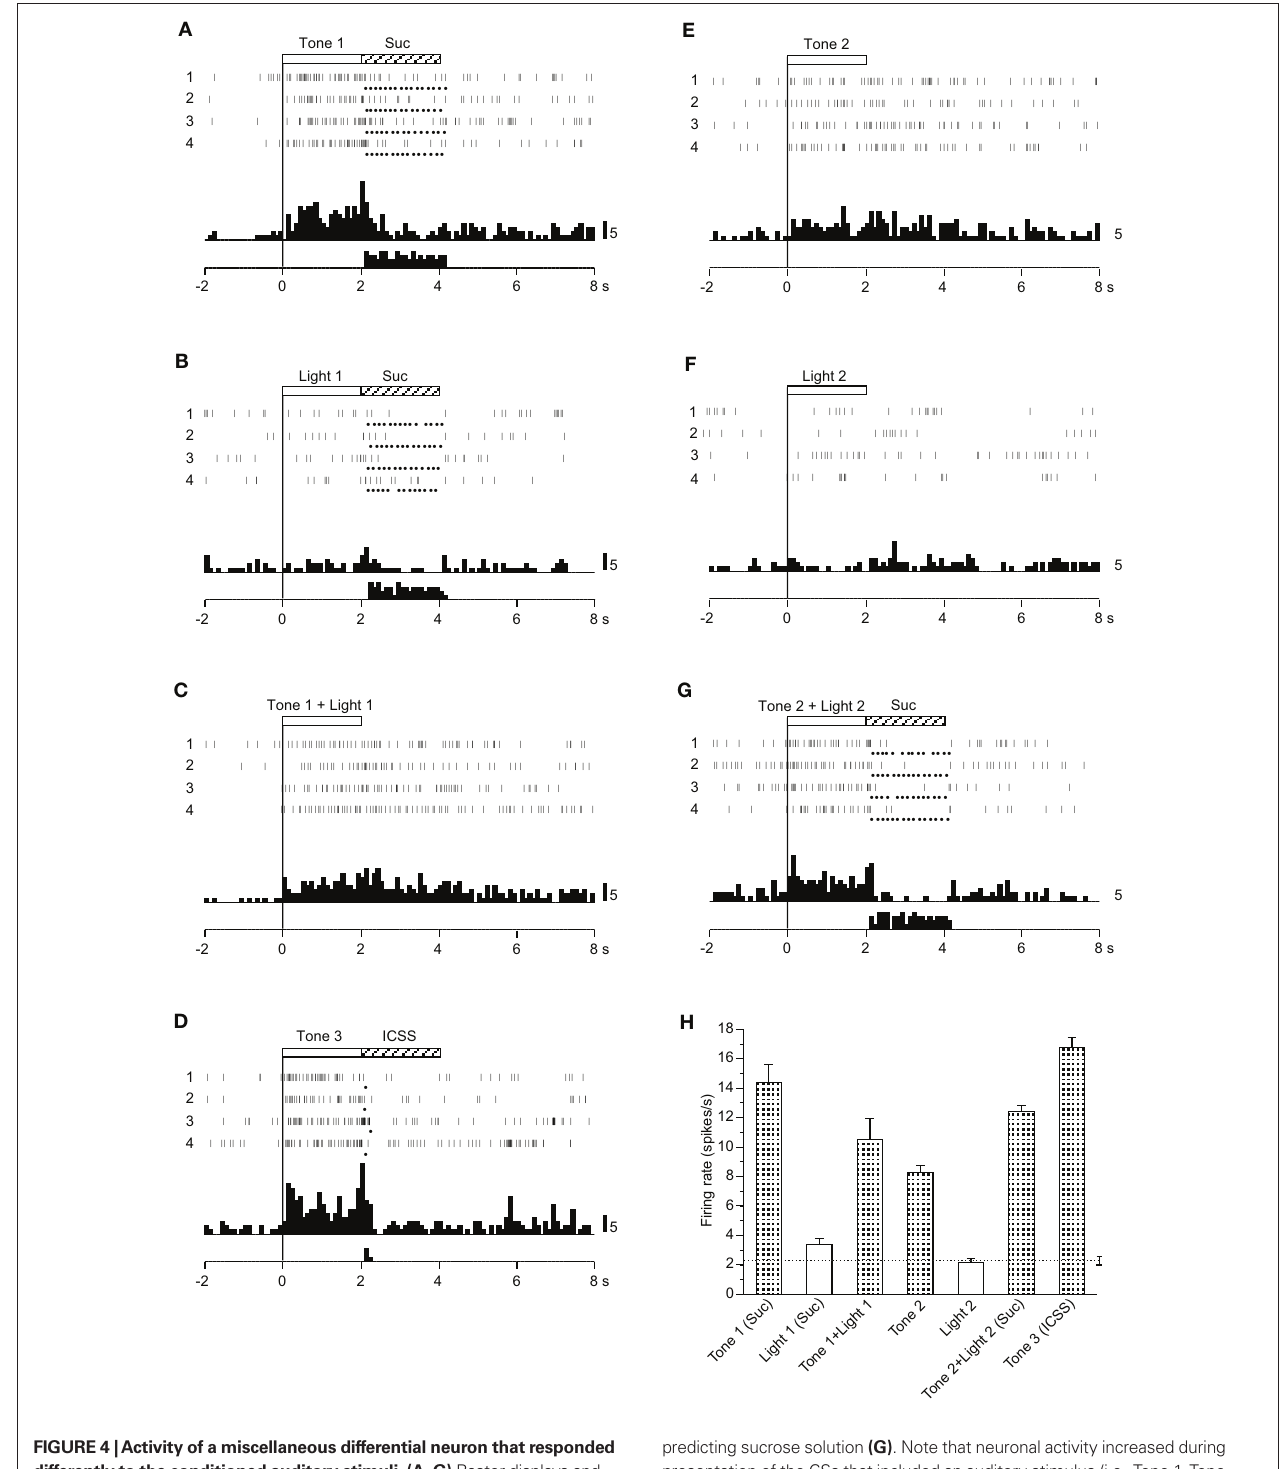
Figure 4 | Activity of a miscellaneous differential neuron that responded differently to the conditioned auditory stimuli. (A–g) Raster displays and histograms of neuronal responses to Tone 1 predicting the sucrose solution (A) , Light 1 predicting the sucrose solution (B) , Tone 1 + Light 1 predicting non-reward (C) , Tone 3 predicting intracranial self-stimulation (ICSS) (D) , Tone 2 predicting non-reward (e) , Light 2 predicting non-reward (F) , and Tone 2 + Light 2